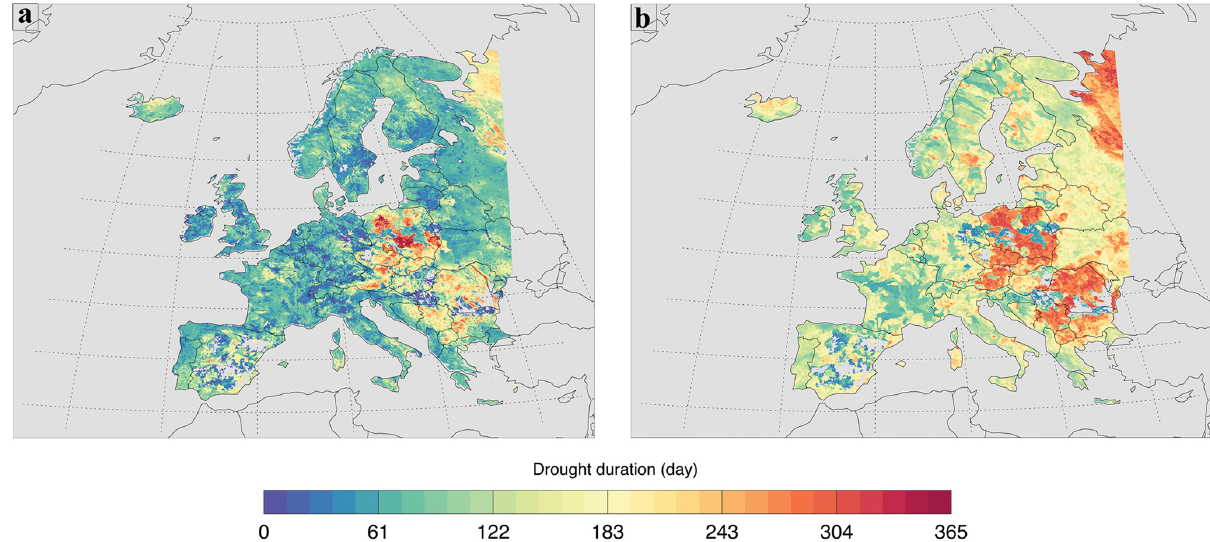
Figure 2. Spatial distribution of the average annual drought duration (days per year in drought years) derived from drought in runoff (a) and groundwater (b) , over the period 1990–2017. Non-drought years are